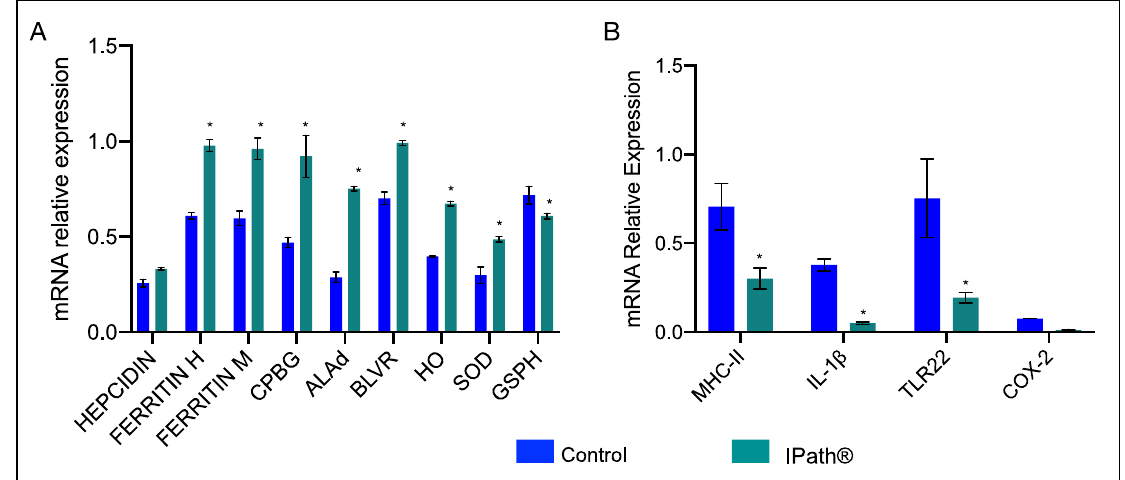
Figure 2. RT-qPCR of ( A ) iron homeostasis and ( B ) immune response-related genes in head kidney of Atlantic salmon injected with IPath ® and control group after 400 accumulated thermal units (ATUs). * Indicates significant differences between IPath ® -vaccinated Atlantic salmon and the control group ( p < 0.005).